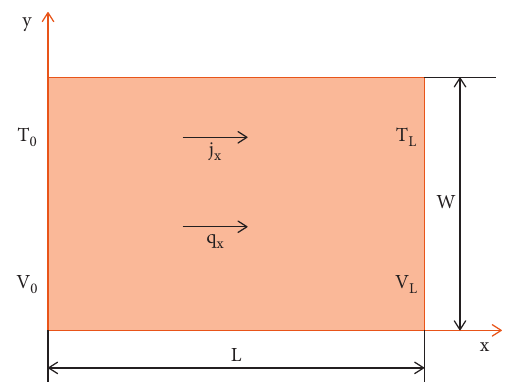
Figure 17: Model geometry and boundary conditions [90].